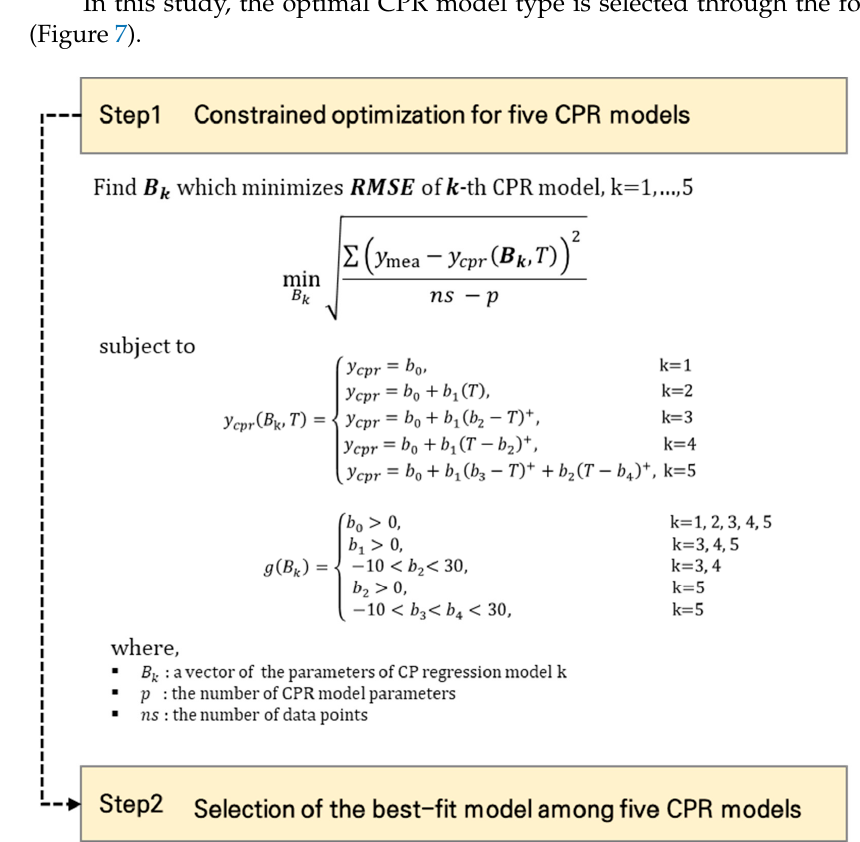
Figure 7. Procedure overview for selecting the optimal CPR model type.